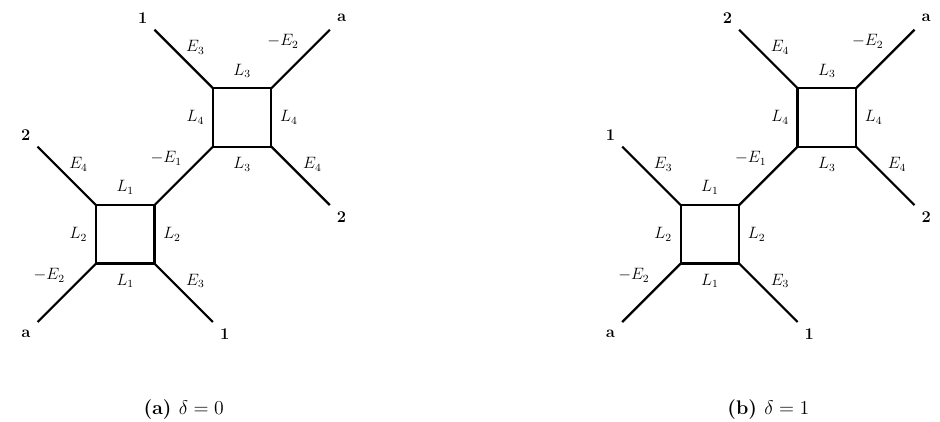
Figure 15 . Gluing two local geometries of the type P 1 (cid:2) P 1 related to the web diagram ( N; M ) = (2 ; 2) with (cid:14) = 0 (diagram (a)) and (cid:14) = 1 (diagram (b)).